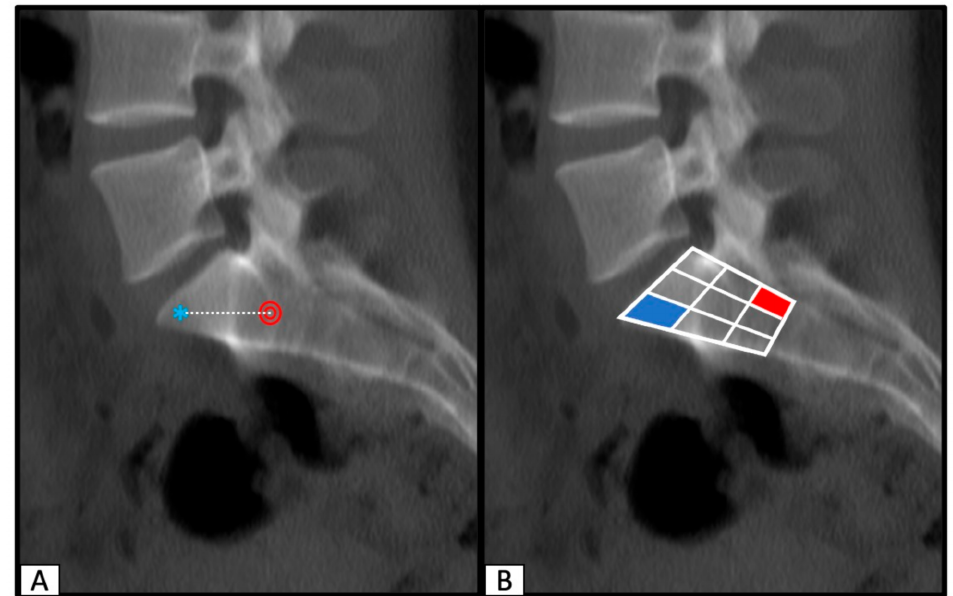
Figure 3. Processed image with the predicted entry- (red circle) and endpoint (blue asterix) of a planned SI screw ( A ). Division of the S1 vertebral body into nine segments to visualize the area for the entry- and endpoint of the SI screw and to predict the direction ( B